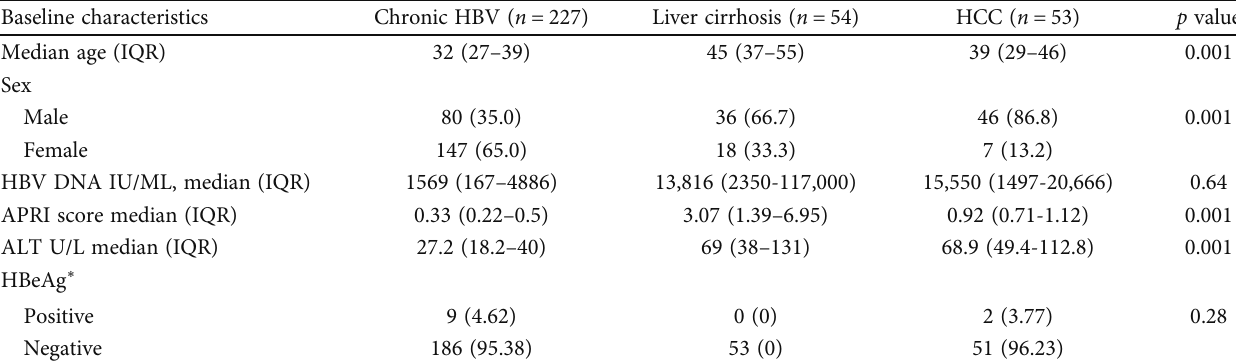
Table 1: Baseline characteristics of study participants.